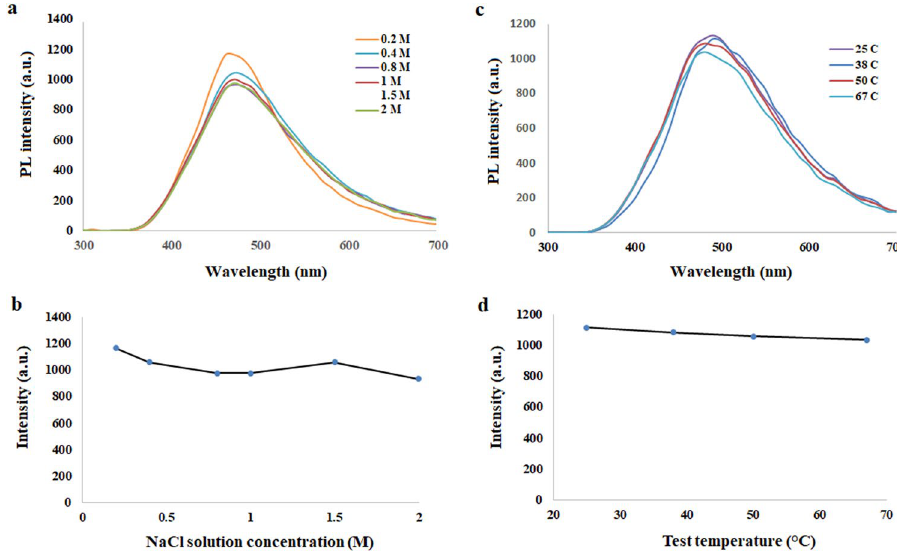
Figure 6. ( a ) The PL spectra of the CQDs in the ionic solutions with different molarity and ( b ) the diagram showing maximum observed PL intensity in different ionic solutions by excitation at 300 nm. ( c ) PL spectra at different temperatures and ( d ) the diagram of maximum observed intensity at different temperatures by excitation at 300 nm.